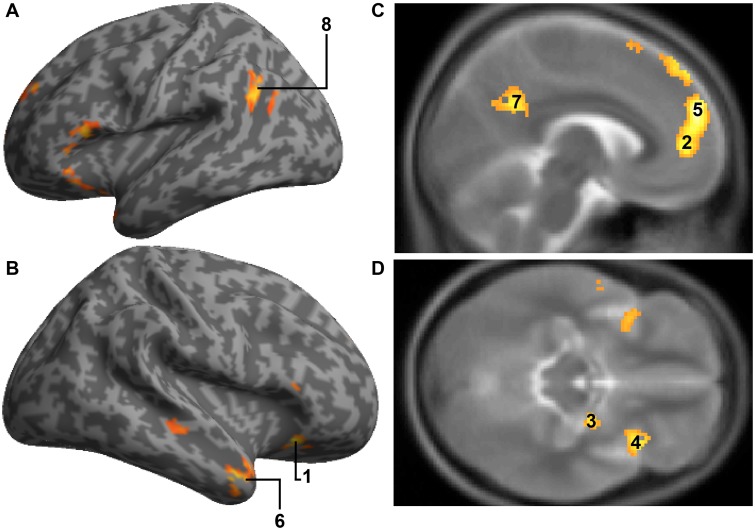
Results of the guilt memory/neutral memory contrast. effects are thresholded at P < 0.001, with a minimum cluster-size of 23 voxels. (A) Left hemispheric activity of the TPJ (8). (B) Right hemispheric activity of the OFC (1) and the Temporal Poles (6) (C) Sagittal view of hemispheric activity of ACC (2), mPFC (5) and precuneus (7). (D) Axial view of hemispheric activity of the amygdala (3) and insula (4).